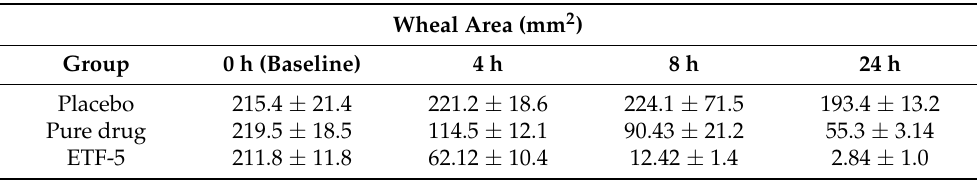
Table 5. Wheal area measurement for antihistaminic efficiency of pure EBT and developed TBF